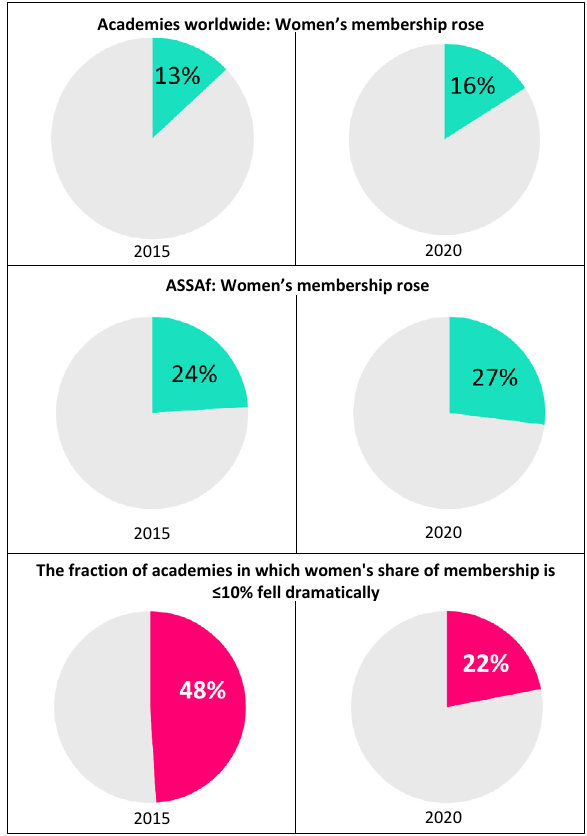
Representation of women in academy membership. Figures are calculated for participants in each survey, in 2020 1 and 2015 7 .